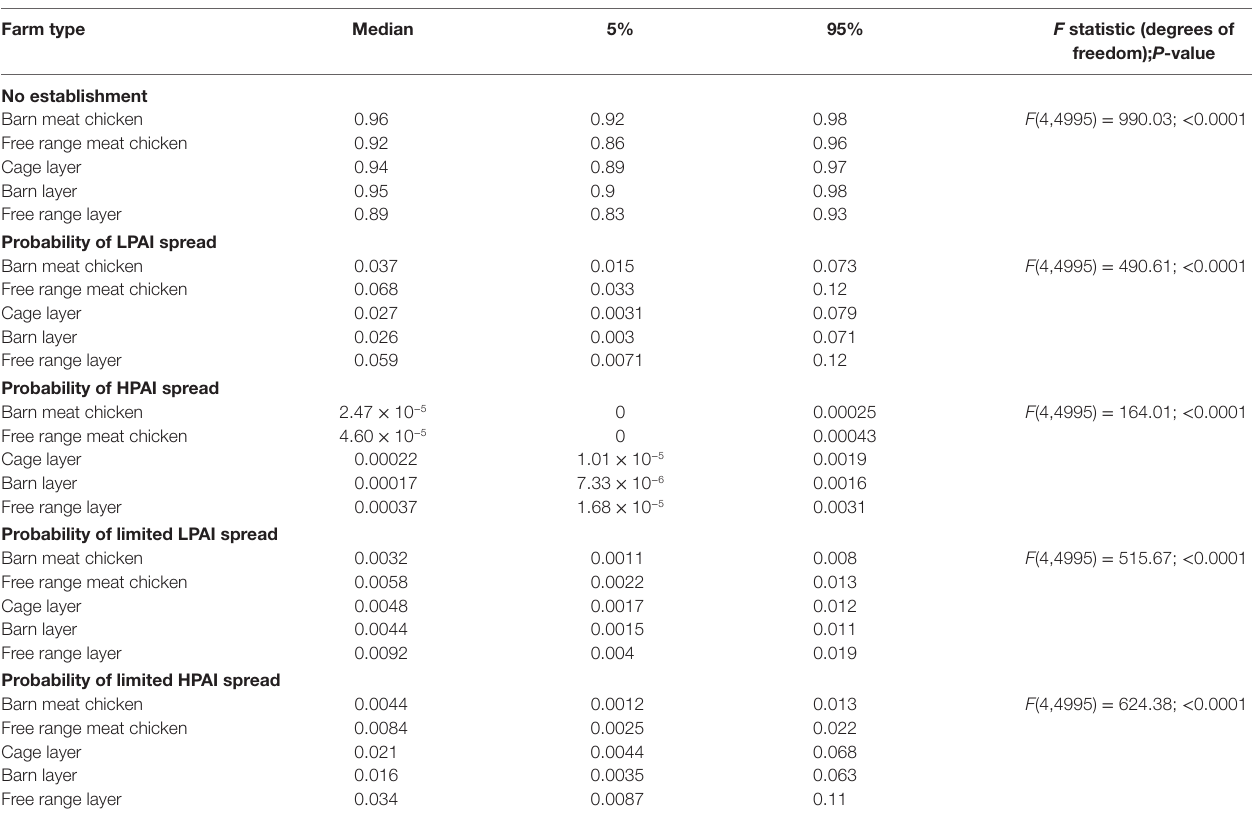
TaBle 2 | Median (5 and 95 percentiles) probabilities of no establishment and of low-pathogenic avian influenza (LPAI) and high-pathogenic avian influenza (HPAI) spread and limited spread between sheds and farms for the commercial chicken farm types (barn meat chicken, free range meat chicken, cage layer, barn layer, and free range layer) after exposure of one chicken to LPAI from one wild bird in Australia.